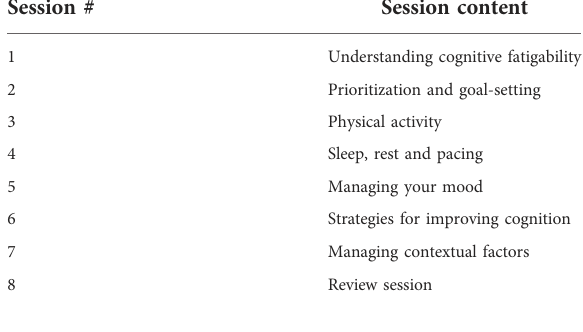
TABLE 1 Intervention session